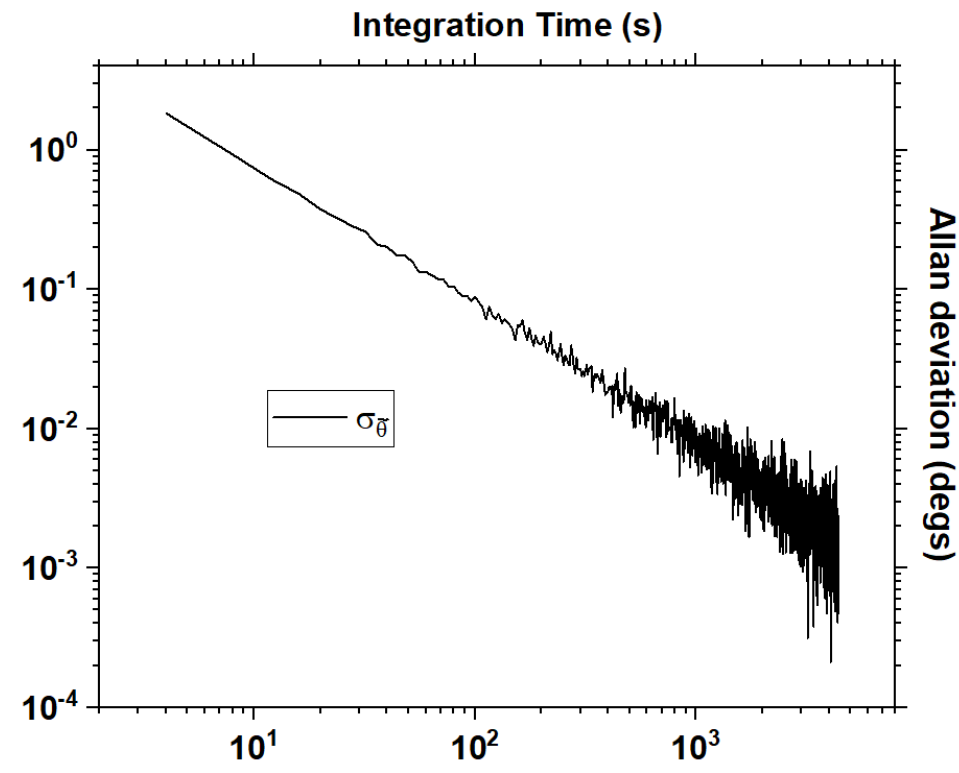
Figure 5. Allan deviation of ˜ θ F , evaluated from long-term